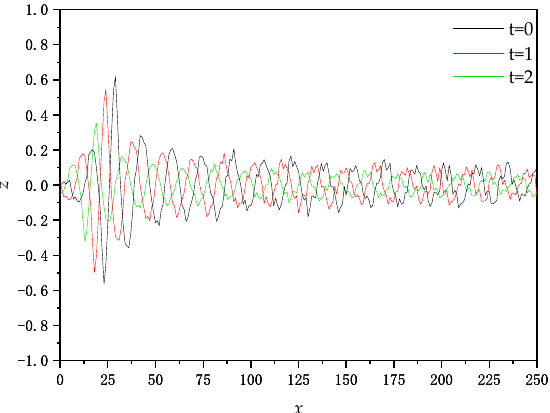
Figure 4. Cross-sectional plot of ship’s induced wake wave height.